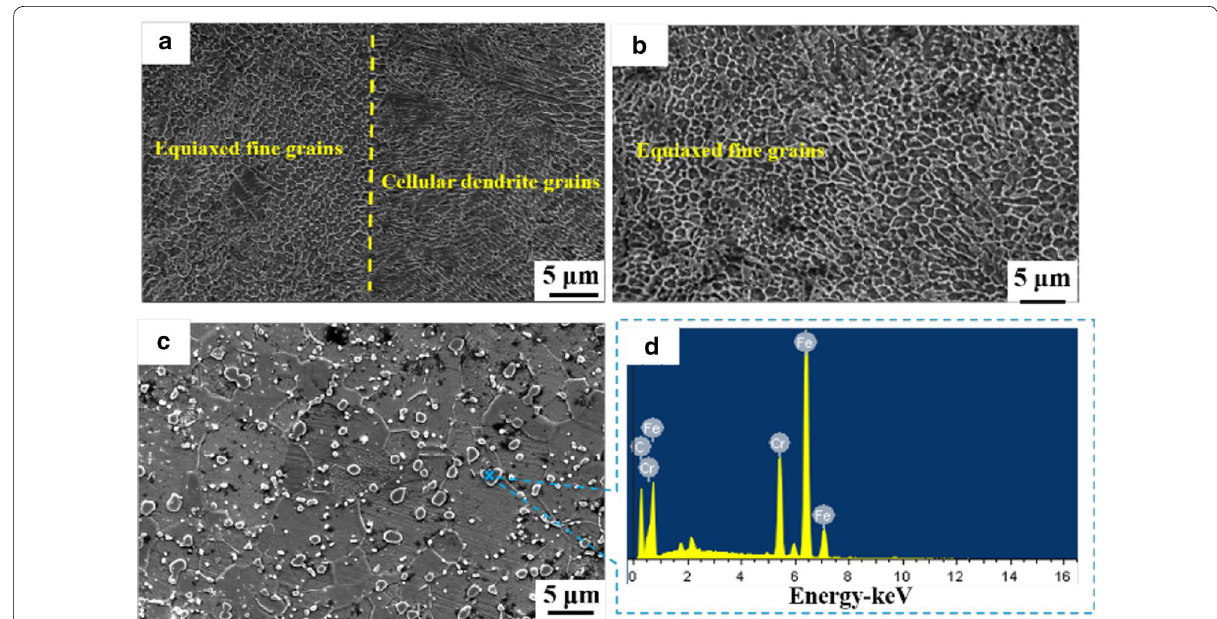
Figure 5 Microstructure of the SLM‑produced and casting S136 parts: a the top view of SLM sample showing two distinct regions; b the side view of SLM sample revealing equiaxed fine grains; c casting state; d EDX point analysis